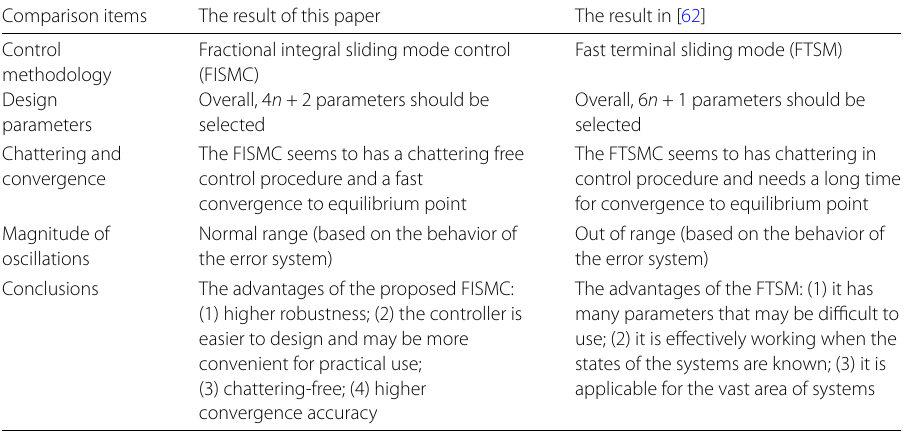
Table 1 Comparison between the results of the FISMC (20) and FTSM (21) Comparison